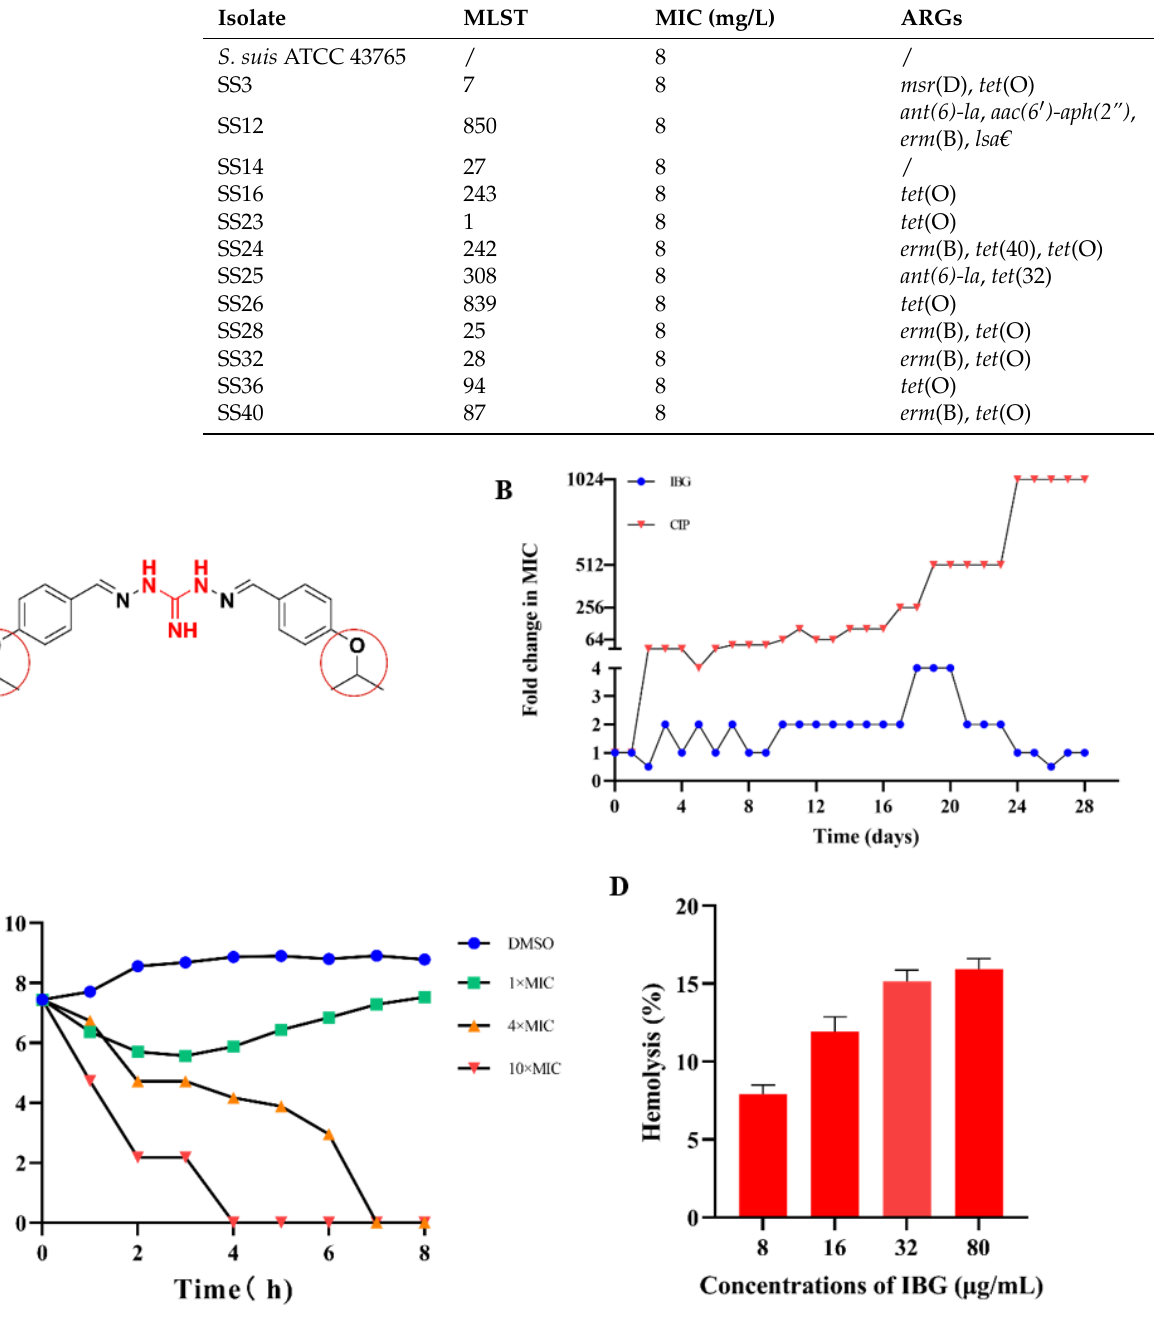
Figure 1. IBG is a potential antimicrobial agent against S. suis . ( A ) The chemical structure of IBG, the guanidine group, is labeled in red, and 4-OCH(CH 3 ) 2 is marked with a red circle. ( B ) No resistance to IBG occurred in the 28-day serial passage. CIP, ciprofloxacin, was used as a control group. ( C ) Time-kill curves of IBG against Streptococcus suis with 1 × MIC (8 µg/mL), 4 × MIC (32 µg/mL), and 10 × MIC (80 µg/mL) concentrations. The 1% DMSO-treated group served as the control group. ( D ) Hemolytic activity of IBG on defibrillated sheep blood erythrocytes.